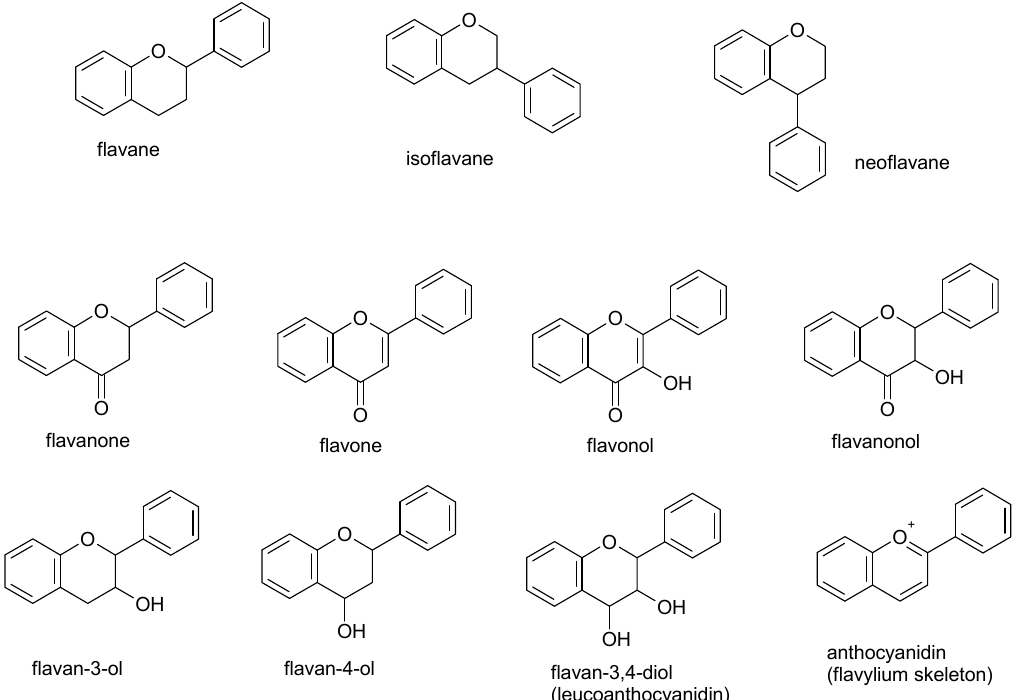
Figure 1. Basic structure of the flavane, isoflavane, and neoflavane backbones, flavanone (2,3-dihydro-2-phenylchroman-4-one) and of the various classes of flavonoids.